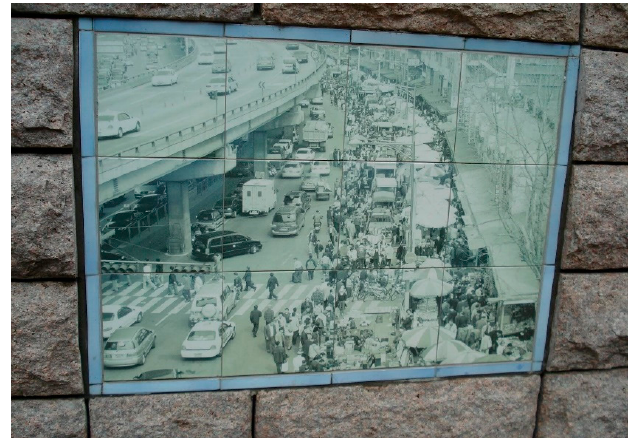
Figure 14. Undated image of the market areas next to the Cheonggyecheon highway overpass.